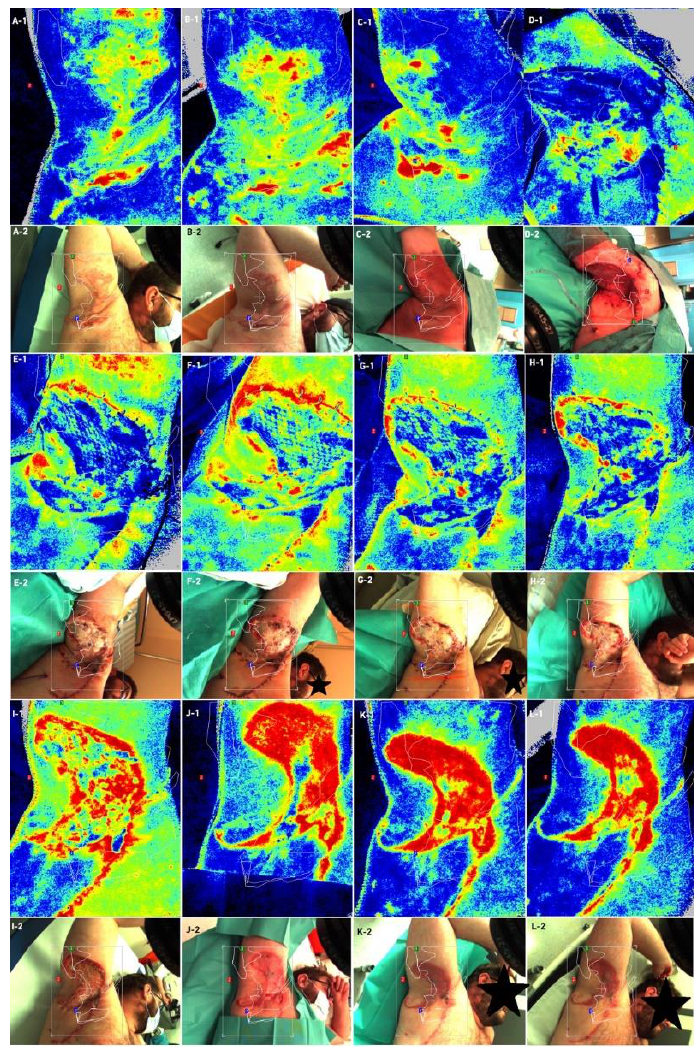
Figure 7. Case 2 — Laser speckle analysis and wound image, A1-B2 — Patient before admission, C1-